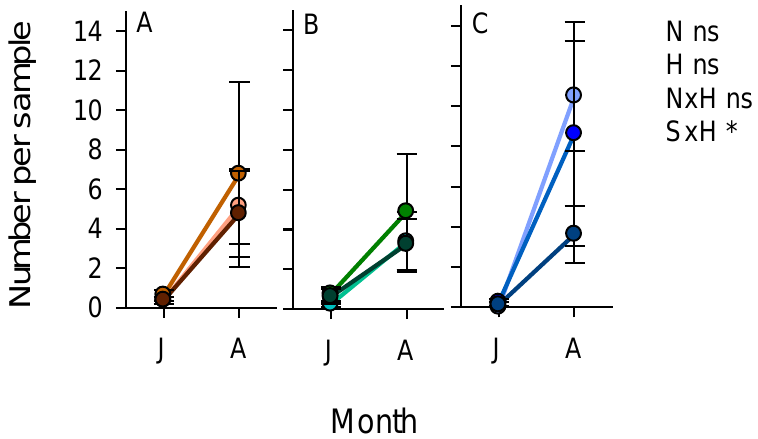
Figure 4. Relative abundance of predatory bugs — mainly Cythorhinus lividipennis — based on sweepnet samples from rice plots during July (J) and August (A) of 2011. Plots were planted with IR66 and received one of three nitrogen-fertilizer treatments (indicated by color intensity of points, N1 = light, N2 = medium, N3 = dark). Samples were collected < 3 m from clear bunds (brown line, A ), weedy bunds (green lines, B ) or sesame/okra bunds (blue lines, C ). Standard errors are indicated ( n = 8). GLM results for effects of nitrogen (N), bund type (H) and their interaction (N × H), and the interaction between crop stage and bund type (S × H) are indicated; ns = p > 0.05, * = p < 0.05. See Supplementary Figure S1 for full details of predators in the rice plots.